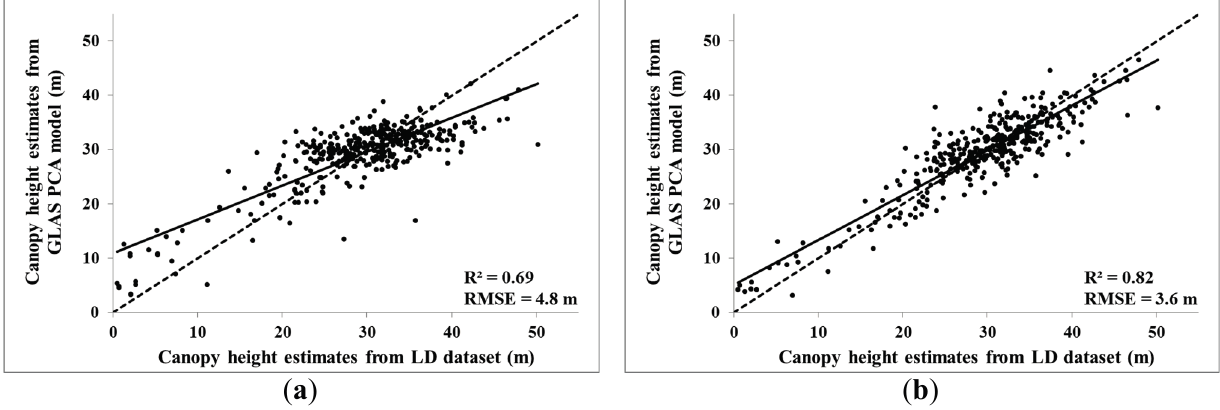
Figure 10. Comparison between canopy height estimates using the most important PCs in Random Forest regression models and those estimated from Low Density airborne LiDAR data (LD) using ( a ) the most important PCs ( PC1 , PC2 , PC4 , and PC11 ) and ( b ) the most important PCs with the waveform